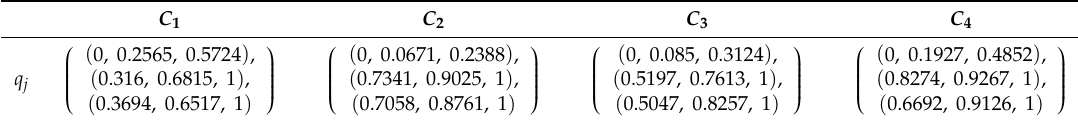
Table 7. The TFNNs-BAA matrix Q